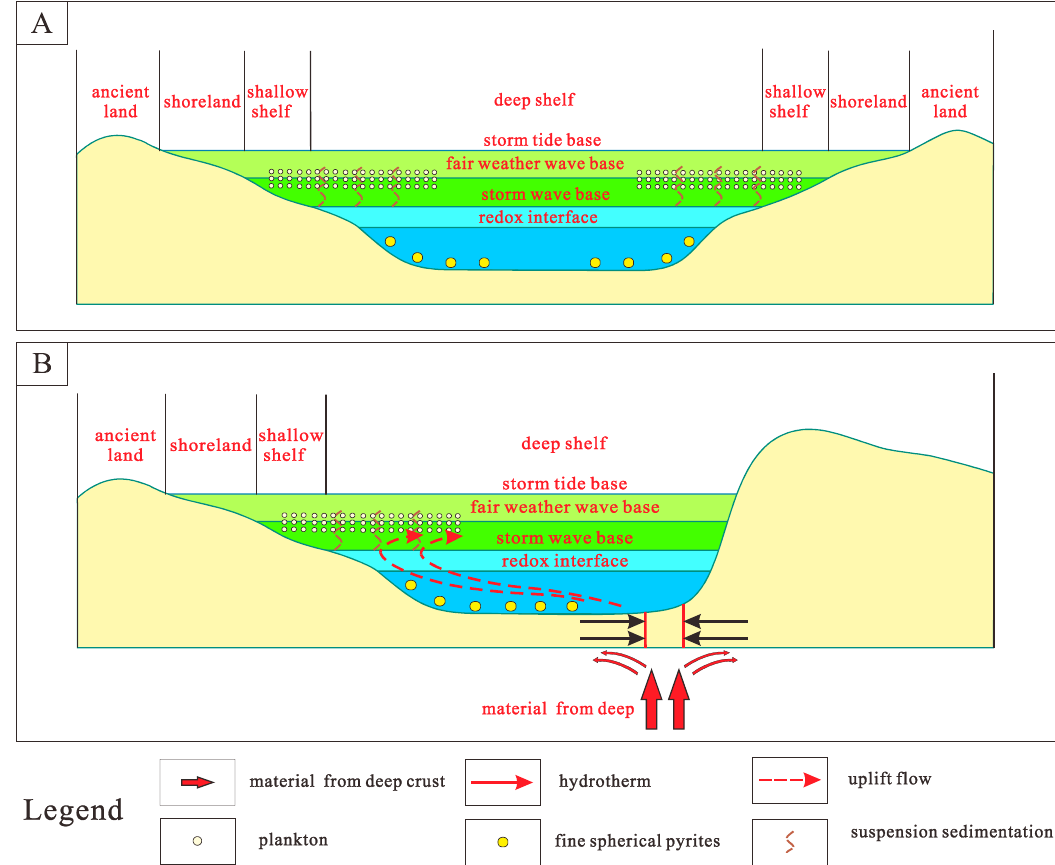
Figure 7. Organic matter enrichment pattern of the Upper Ordovician–Lower Silurian shale in the Upper-Lower Yangtze area. The Upper Yangtze area ( A ) and Lower Yangtze area ( B ).